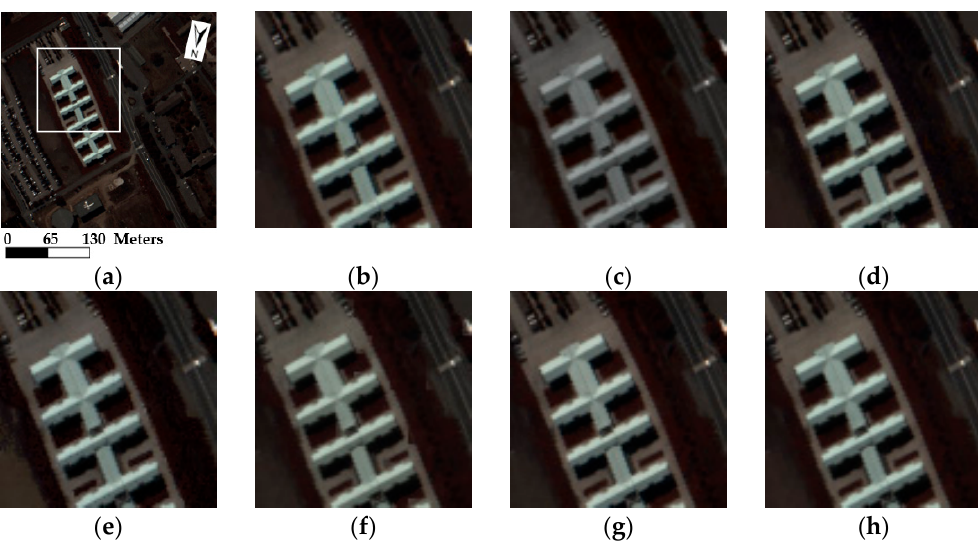
Figure 12. Comparison of fusion results (S = 8) on image Pavia University with bands 31, 21, and 11 as red, green, and blue, respectively: ( a ) Pavia University and the area-of-interest (white square); ( b ) original HR-HSI; ( c ) PCA [42]; ( d ) MF [22]; ( e ) SSFM [23]; ( f ) GSOMP [14]; ( g ) BSR [24]; and ( h ) PG-NLSR.